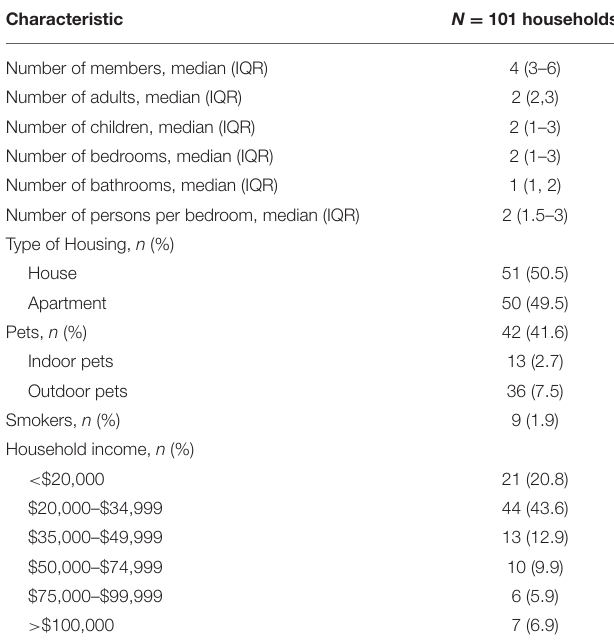
TABLE 1 | Characteristics of households enrolled in a prospective study of SARS-CoV-2 household transmission—Los Angeles, California,